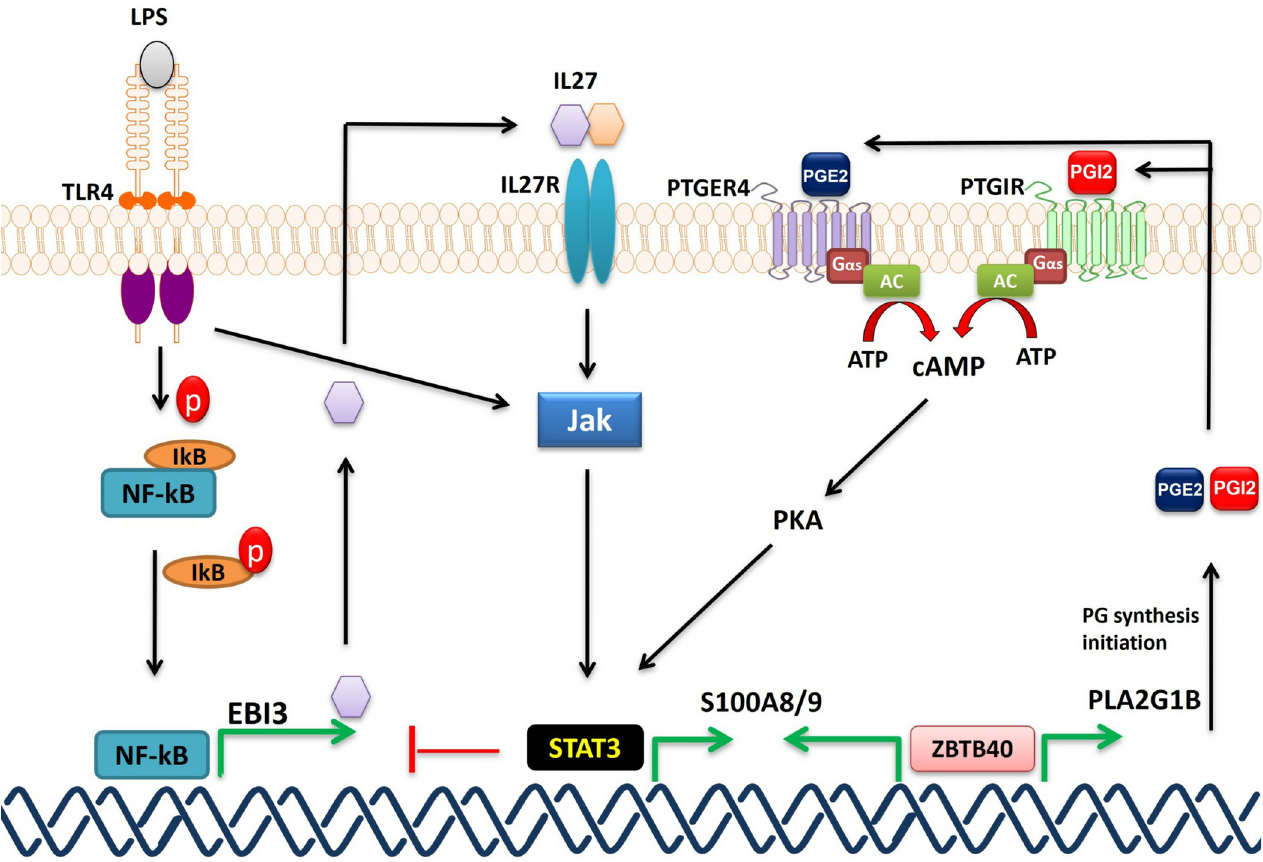
Fig 7. Proposed model of S100A8/9 induction. PTGIR and PTGER4 are activated by their ligands (PGI2 and PGE2 respectively) turning on the AC which converts ATP into cAMP; cAMP activates PKA which in turn triggers STAT3 by phosphorylation. STAT3 binds to the promoters ( S9 Fig ) of S100A8 and S100A9 inducing their expression. TLR4 and when activated by its ligand LPS, activates the JAK2-STAT3 pathway which induces the expression of S100A8/9 and inhibits NF-kB. We have shown the induction of S100A8/9 genes in THP-1 activated by LPS (Fig 5) . ZBTB40 could potentially bind directly to the S100A8/9 promoters inducing their expression and/or to the PLA2G1B promoter ( by Encode ) activating its expression. PLA2G1B encodes an enzyme that initiates the PG synthesis including PGI2 and PGE2 which bind PTGIR and PTGER4 respectively, inducing S100A8/S100A9 (see above). Based on RNAseq data, expression of NFKB1 in THP-1 induces the expression of EBI3 (one of the top 5 HITS) ( S3A Table ) most likely via direct binding to the EBI3 promoter by RELB subunit. EBI3 encodes the interleukine-27 subunit beta, which can bind to IL27R and activate JAK/STAT3 pathway [55,56].In addition, NFKB1 induces the expression of PTGIR ( < 2 FC, RNAseq data) and by LPS (S10 Fig). RELB binds directly to PTGIR promoter ( by Encode